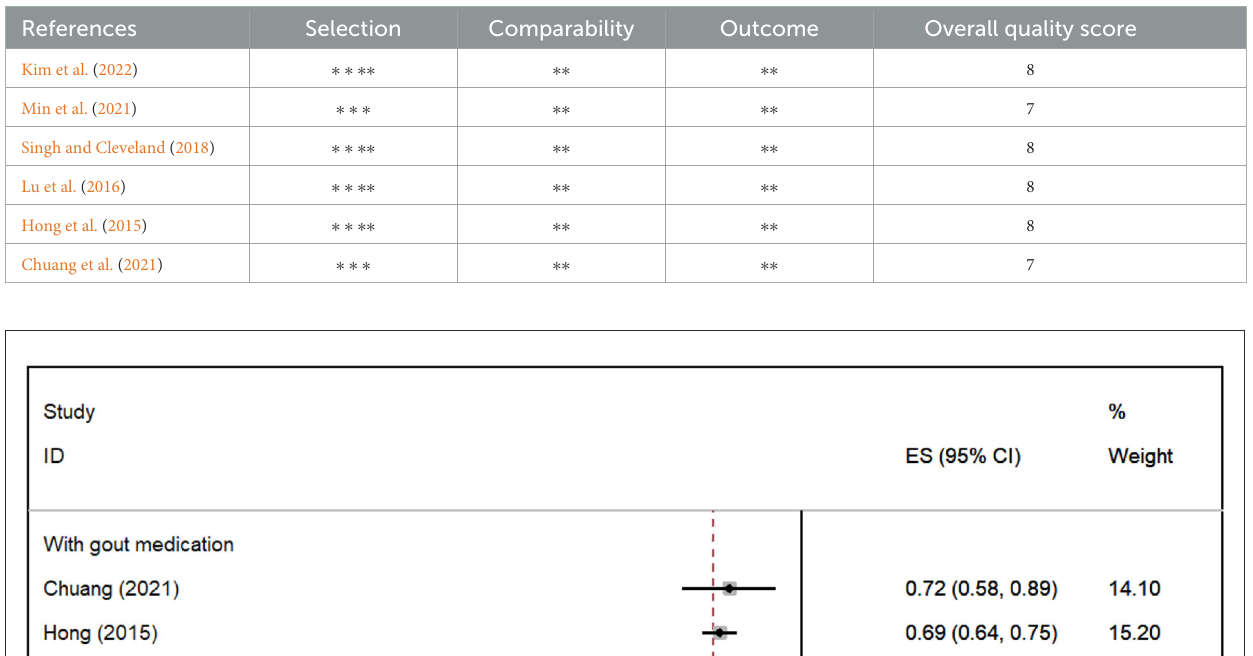
TABLE 2 Newcastle-Ottawa quality of cohort studies.